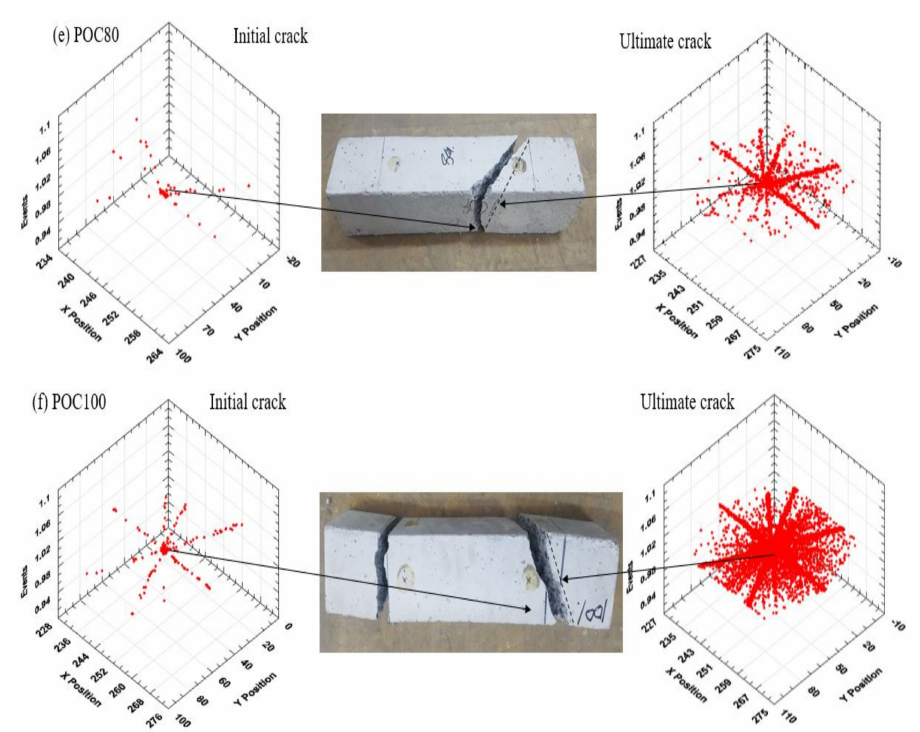
Figure 9. Crack mapping and profile of initial cracks, concrete specimen, and ultimate cracks for ( a ) 0%, ( b ) 20%, ( c ) 40%, ( d ) 60%, ( e ) 80%, and ( f ) 100% replacement levels of POC coarse